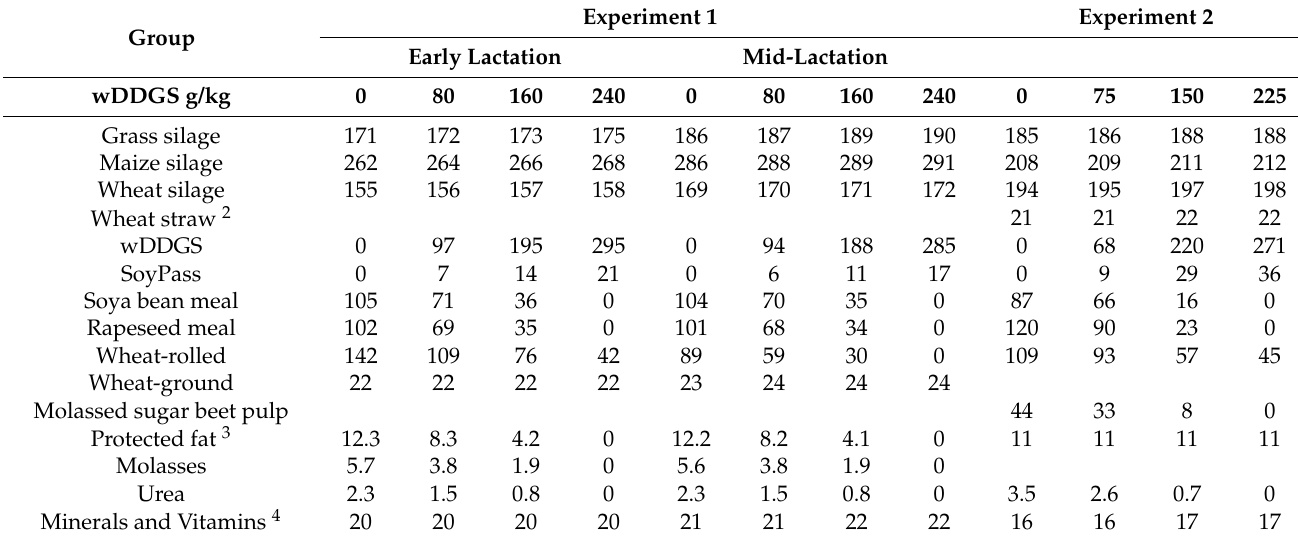
Table 1. Ingredient composition 1 of partial-mixed rations containing four levels of wheat-based dried distillers’ grains with solubles